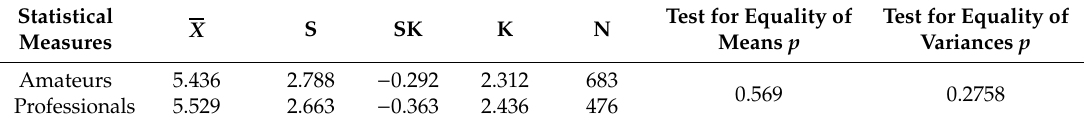
Table 8. Statistical characteristics of the relatively high prices of services at sports and recreation facilities, in the opinion of service recipients.